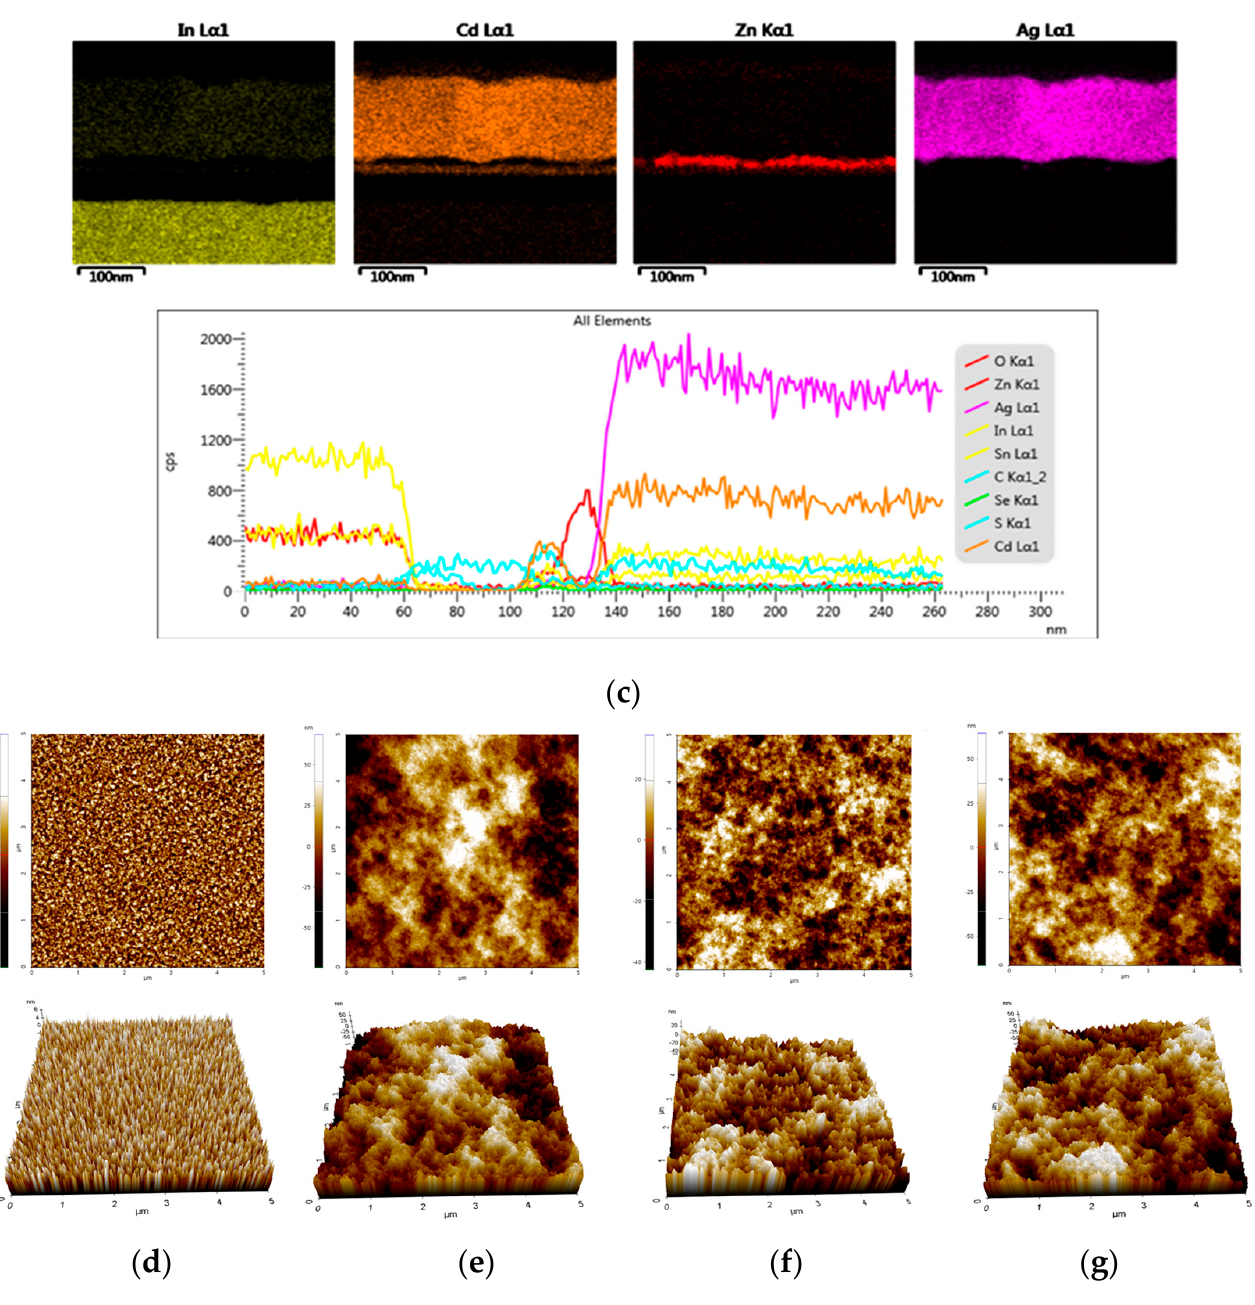
Figure 12. Cross-sectional HR-TEM images of QLEDs with ( a ) ZnO-OA(0.5 mL)/ZnO and ( b ) ZnO-OA (1.0 mL)/ZnO QDs double ETL. ( c ) EDS line mapping and line scan profile over the cross-sec- tional area of ITO//CdSe/ZnS//ZnO-OA (0.5 mL) QDs/ZnO QDs. AFM images over the surfaces of ( d ) ITO/CdSe-ZnS QDs, ( e ) ITO//CdS/ZnS//ZnO QDs, ( f ) ITO//CdSe/ZnS//ZnO-OA(0.5 mL) QDs/ZnO QDs, and ( g ) ITO//CdSe/ZnS//ZnO-OA(1.0 mL) QDs/ZnO QDs.